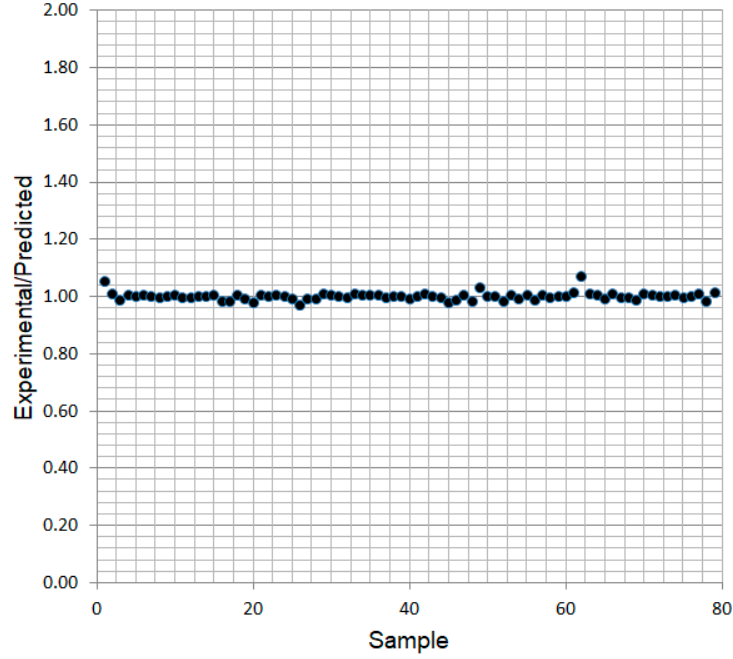
Figure 18. Experimental versus predicted values of convergence for training datasets.